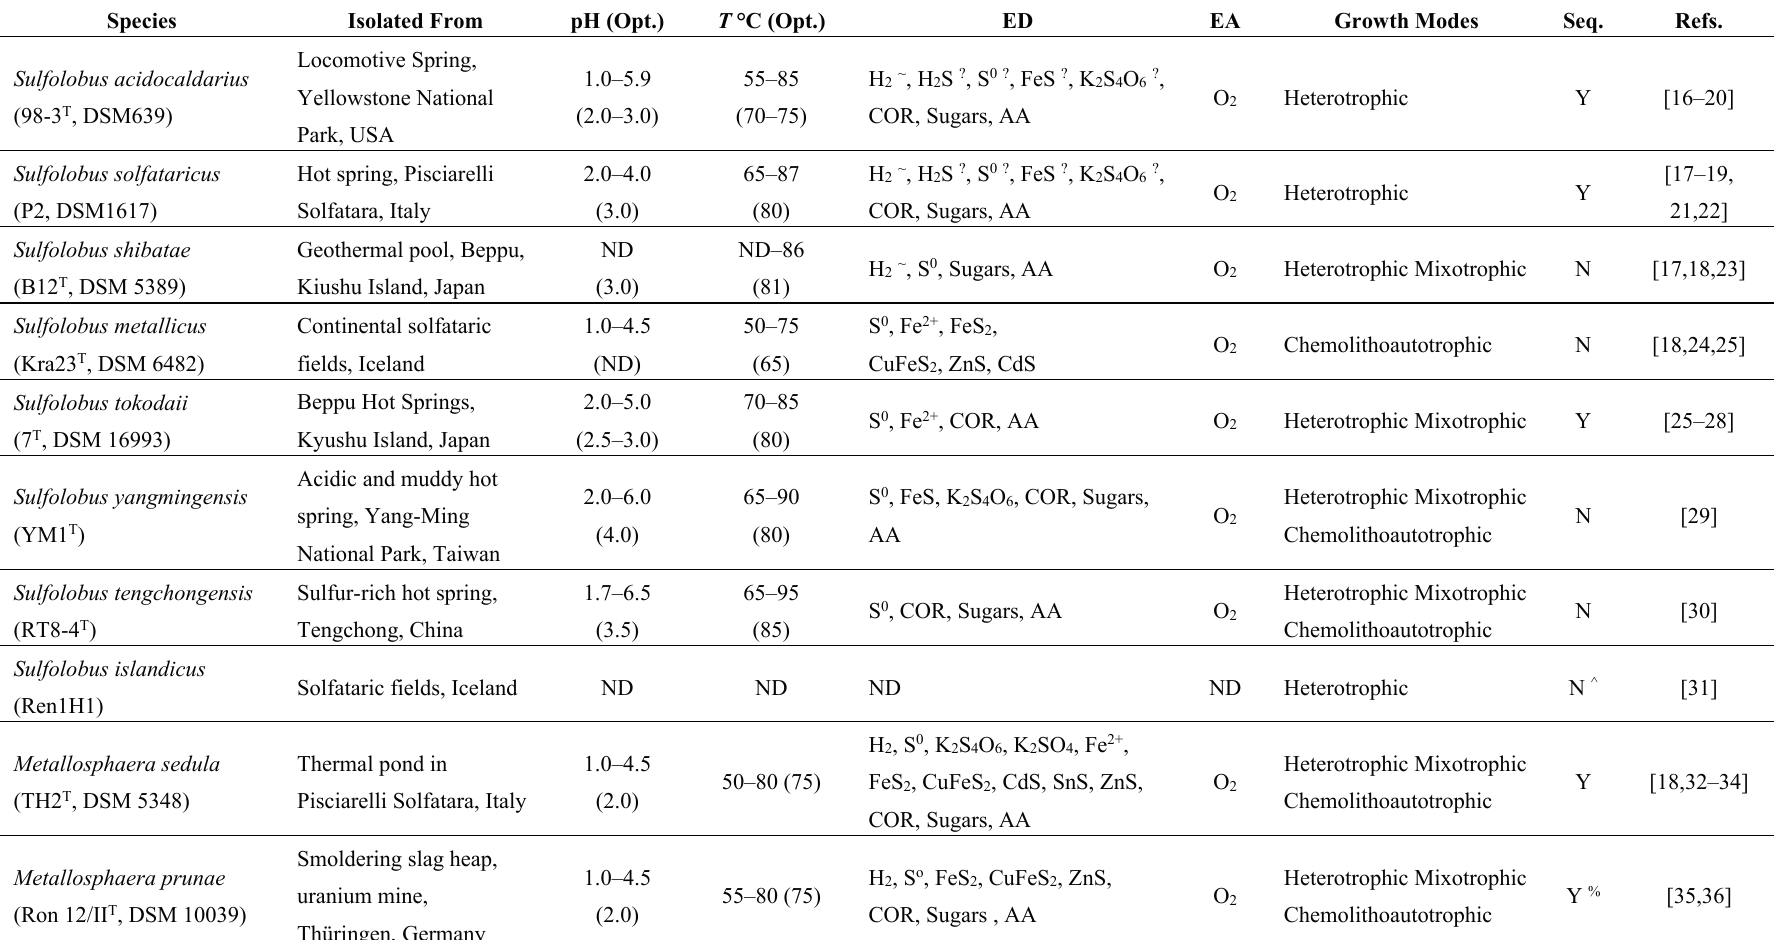
Table 1. Growth physiology information for the Sulfolobales. (Opt.) Optimum, (ED) Electron donor, (EA) Electron acceptor, (Seq.) Genome sequenced, (ND) Not determined, (COR) Complex organic compounds, (AA) Amino Acids. Species Isolated From pH